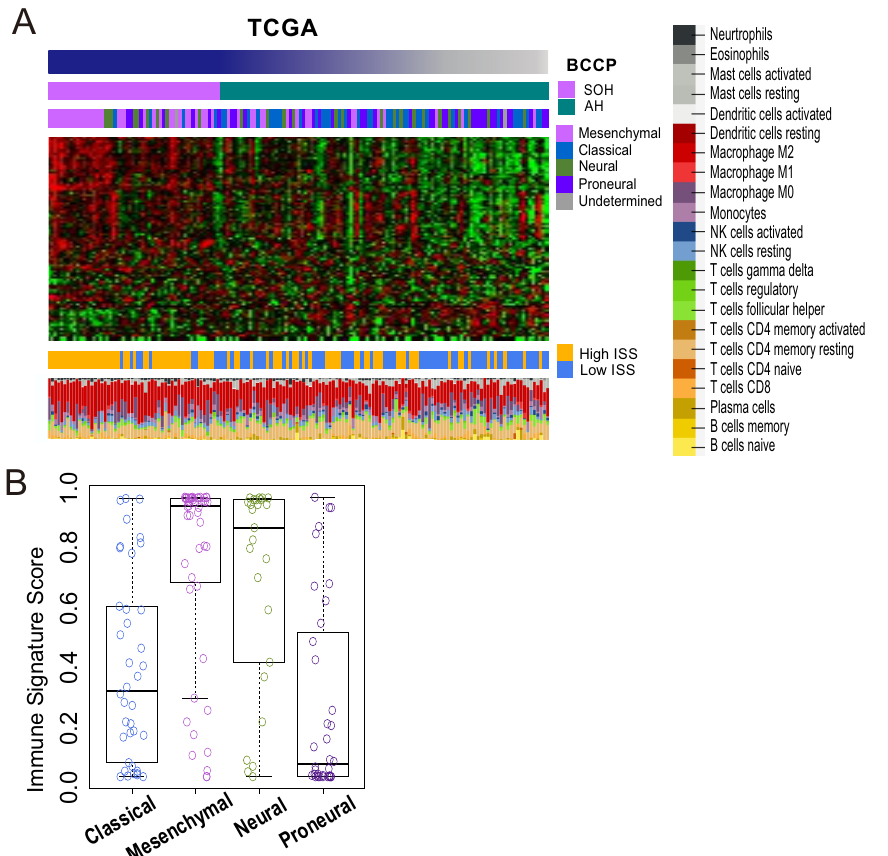
Figure 6. Immune signature of glioblastoma (GBM) samples from The Cancer Genome Atlas (TCGA). The immune signature score (ISS) was predicted for each of the 154 samples on the basis of a 105-gene immune signature generated from a comparative analysis of responders and nonresponders to immunotherapy. ( A ) In a heatmap showing the core immune signature of the 154 samples, high ISS was more common in the silence of Hippo (SOH) subgroup ( p < 0.001). Leukocyte subset analysis (CIBERSORT) showed that the proportion of M2 macrophages in GBM tumor tissue was much higher in the SOH subgroup than in the active Hippo (AH) subgroup. BCCP, Bayesian covariate compound predictor. ( B ) ISS was apparently highest in the mesenchymal subtype, followed by the neural subtype, and it was lowest in the proneural